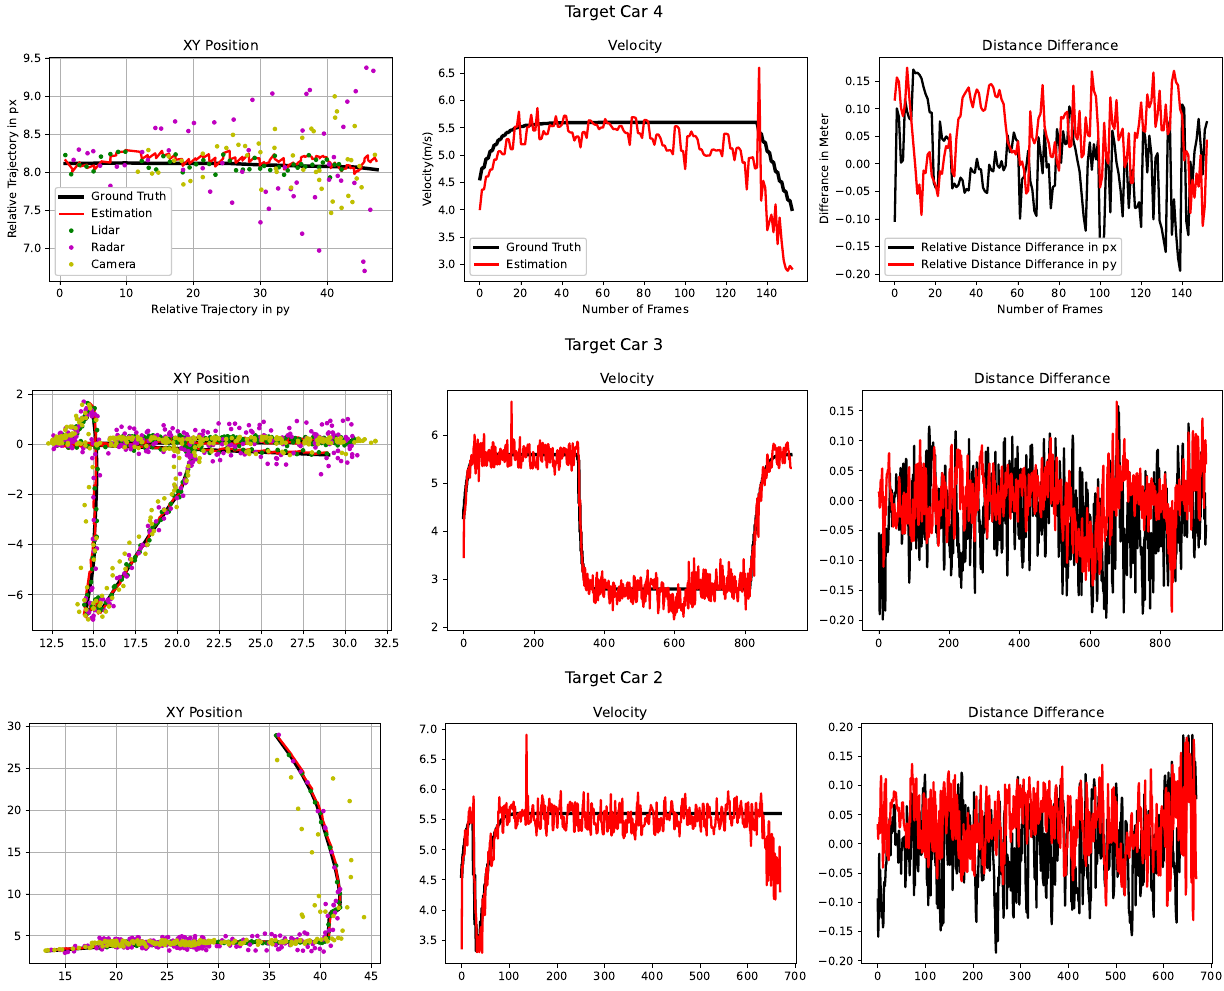
Figure 5. Frame-by-frame comparison between tracking results and ground truth for the first scenario. In the XY position graph, green, pink, and yellow are generated LiDAR, radar, and camera measurements, respectively. Radar (polar coordinate system) and camera (pixel coordinate system) measurements were converted to the Cartesian coordinate system for visualization